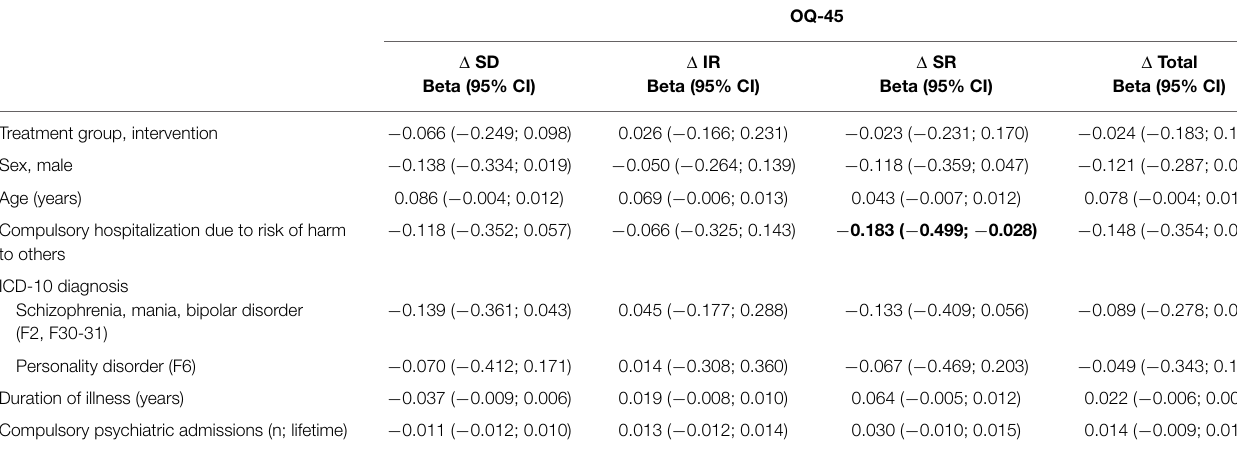
TABLE 4 | Self-reported mental health functioning: predictors of changes (regression analysis, standardized regression coefficients, and 95% confidence intervals)